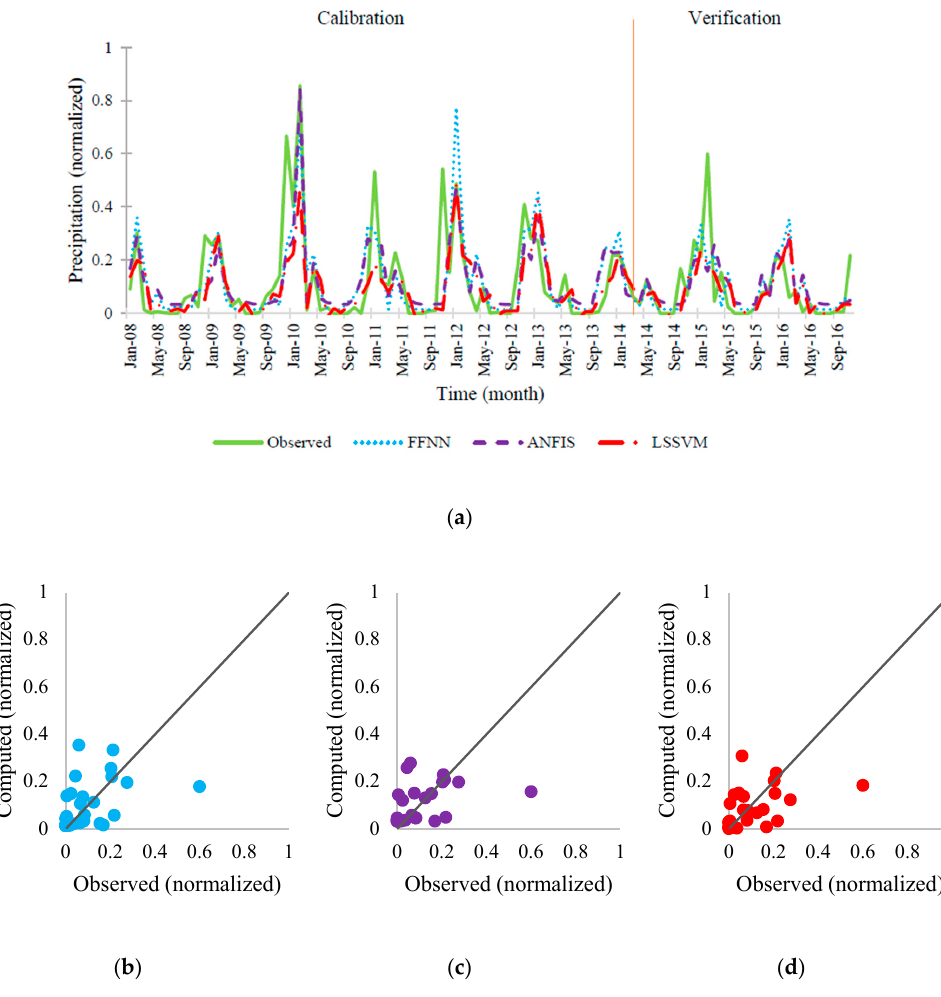
Figure 10. ( a ) Observed versus computed precipitation time series by FFNN, ANFIS and LSSVM models. Scatter plots for verification step for ( b ) FFNN; ( c ) ANFIS; ( d ) LSSVM models via scenario 1 for Girne station.